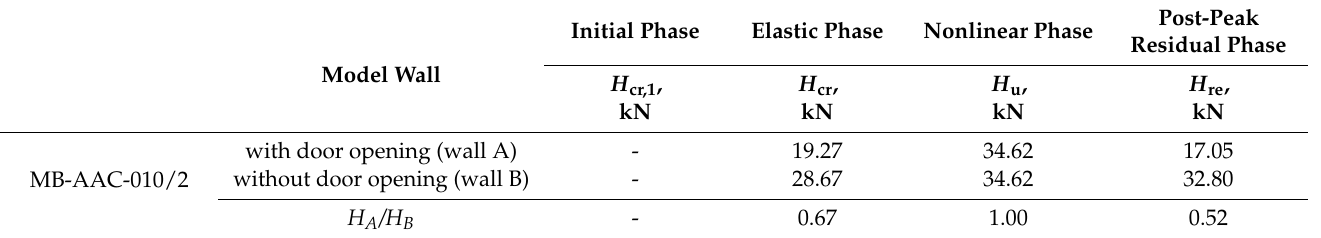
Table 6. Forces acting on stiffening walls in the MB-AAC-010/2